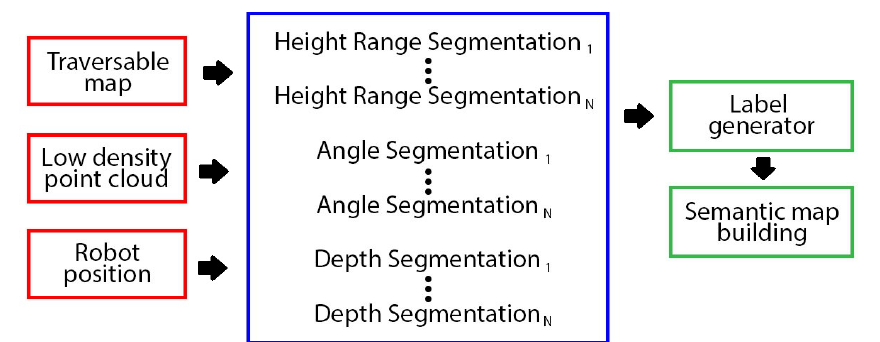
Figure 2. The architecture of our proposed approach for semantic mapping, based on multiple segmentation methods applied to detect different types of objects.